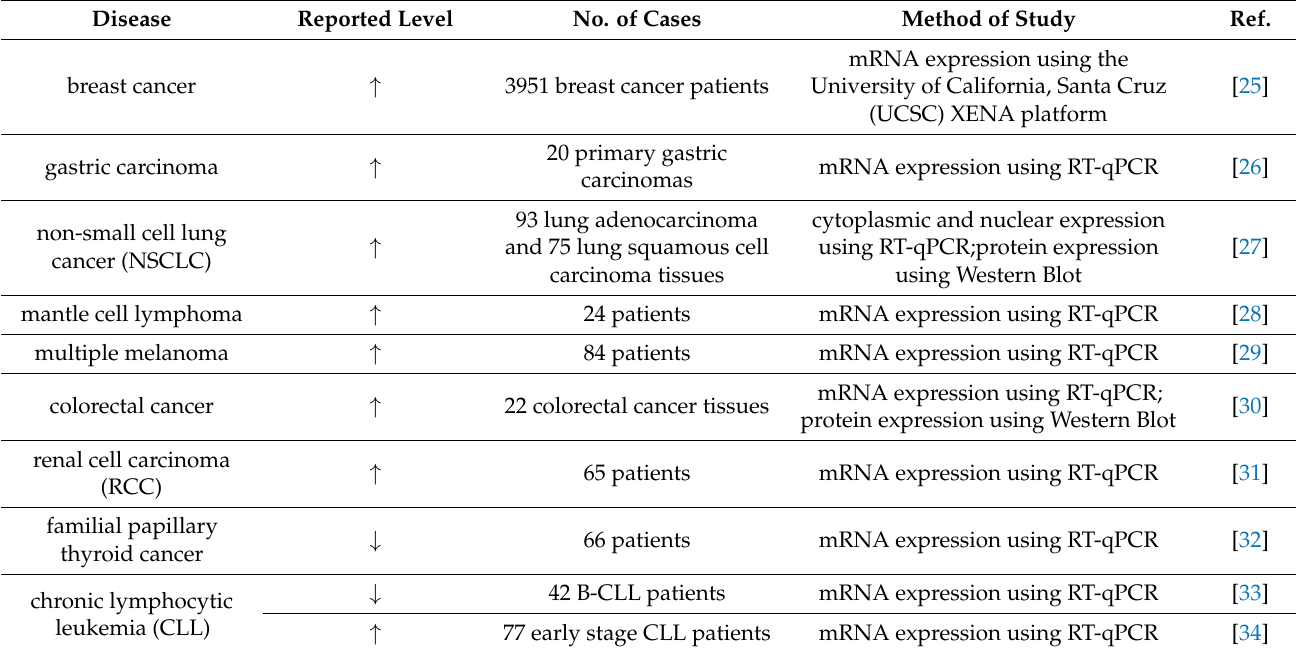
Table 2. The differential expression of RAP1 in selected human